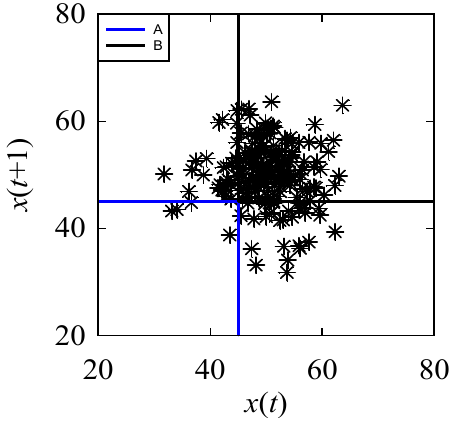
Figure A2. Relative position of A and B in the point-cloud ( x ( t ), x ( t + 1)).